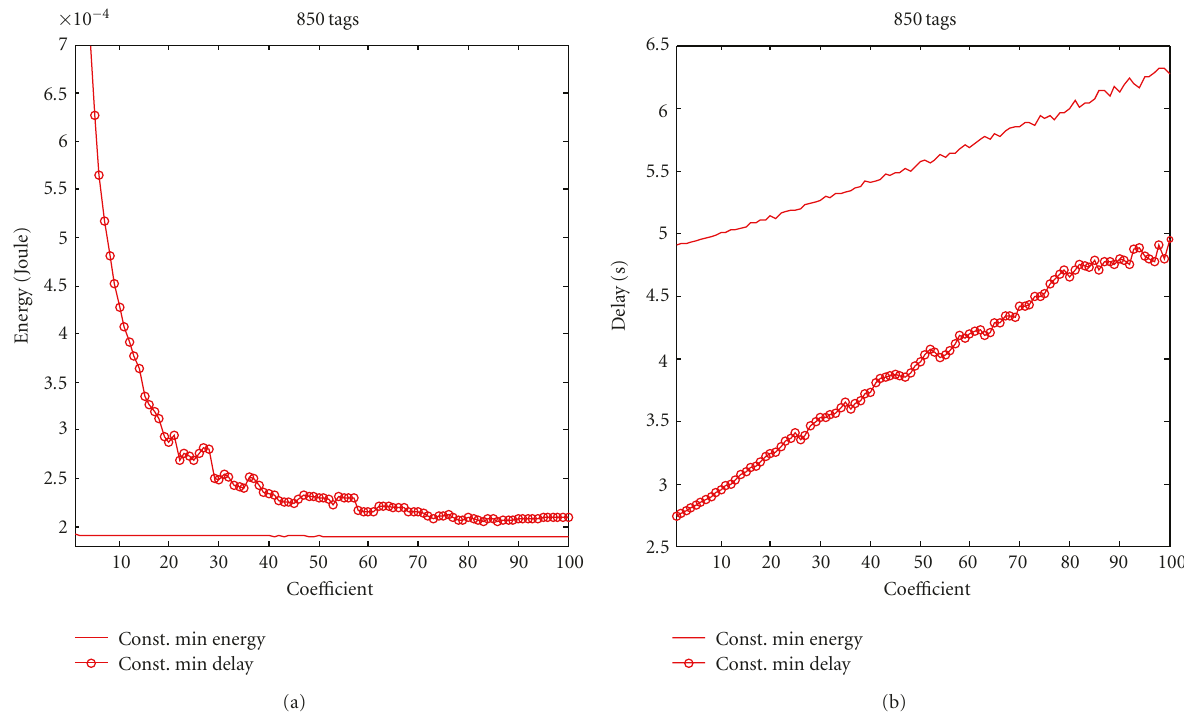
Figure 14: The energy-delay trade o ff in the case of 850 tags and the constant algorithm. (a): Energy consumption as a function of the back-o ff coe ffi cient. (b): Delay as a functions of the back-o ff coe ffi cient. “Lines with circles” show when the ICW has been selected in order to minimize the delay. The “plain” lines show when the ICW has been selected in order to minimize